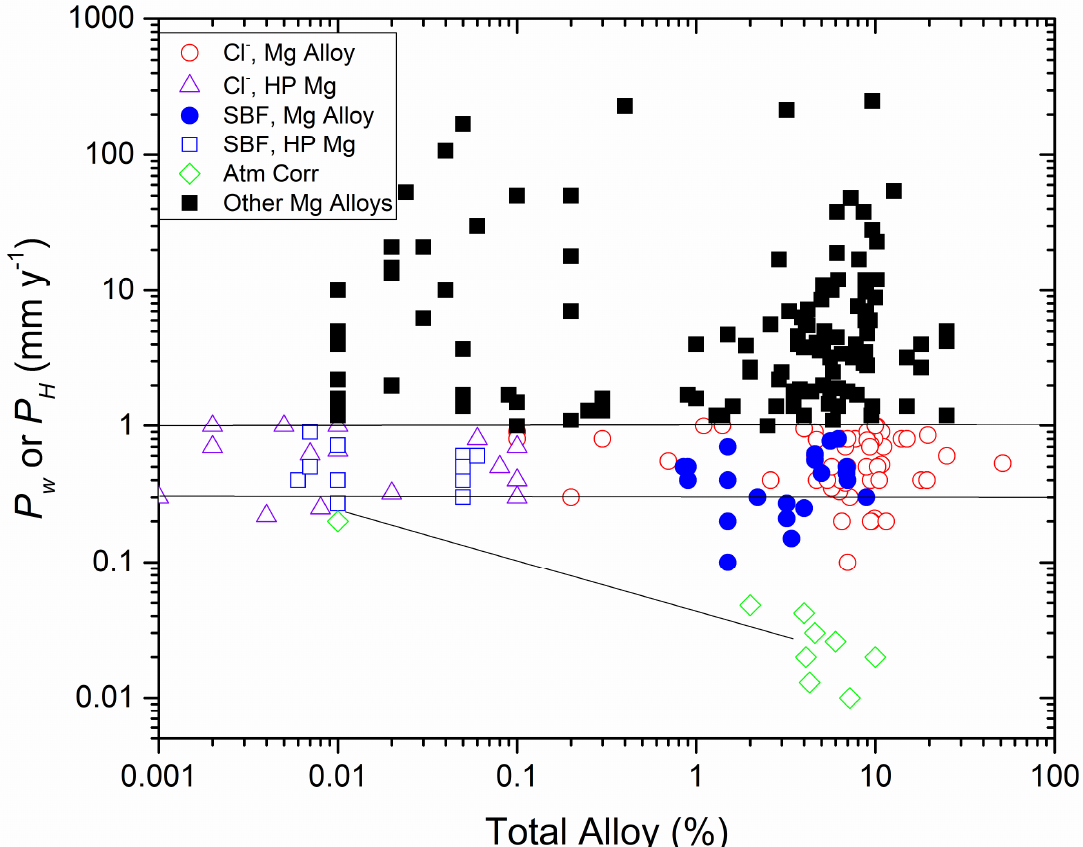
Figure 9. A recent compilation [83] of corrosion rates of Mg alloys that was focused on Mg alloys with low corrosion rates.